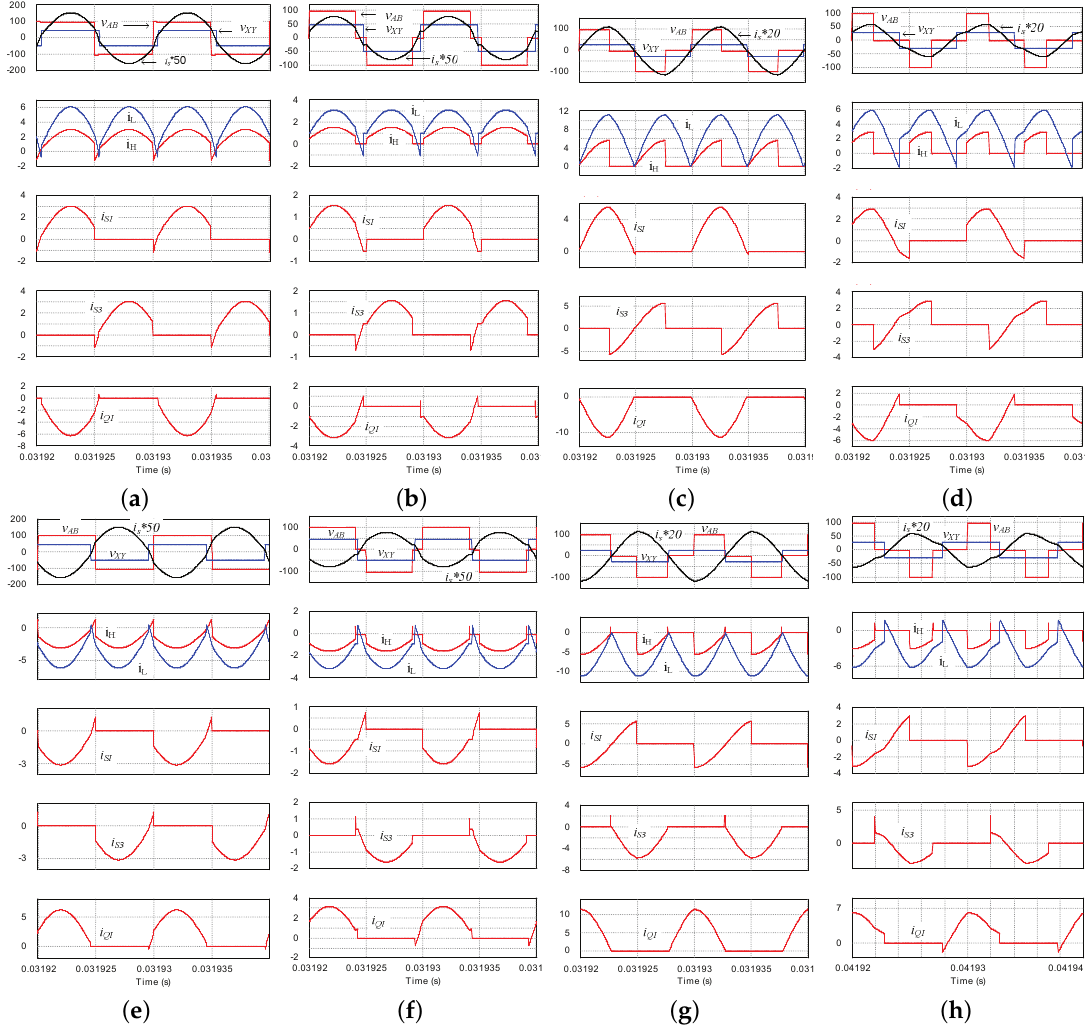
Figure 9. Simulation plots at V H = 100 V and: ( a ) V L = 48 V, output power P o = 200 W; ( b ) V L = 48 V, output power P o = 100 W; ( c ) V L = 28.8 V, output power P o = 200 W; ( d ) V L = 28.8 V, output